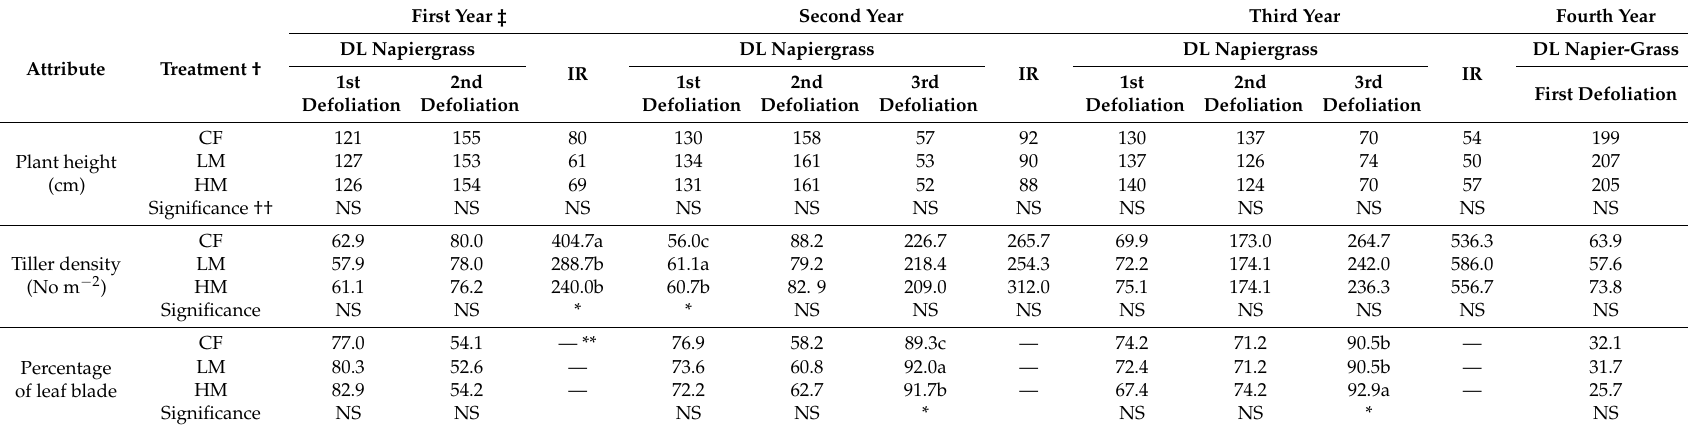
Table 2. Growth attributes of plant height, tiller density, and percentage of leaf blade in dwarf genotype of late-heading type (DL) Napiergrass and Italian ryegrass (IR), as affected by fertilizer treatments for four consecutive years